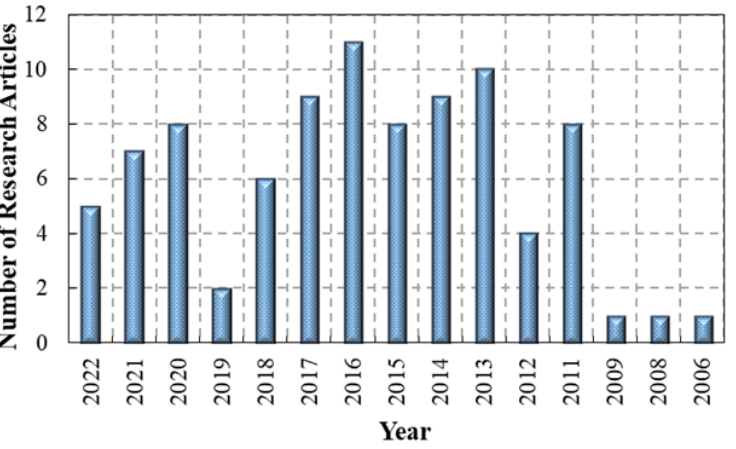
Figure 3. Publications frequency.